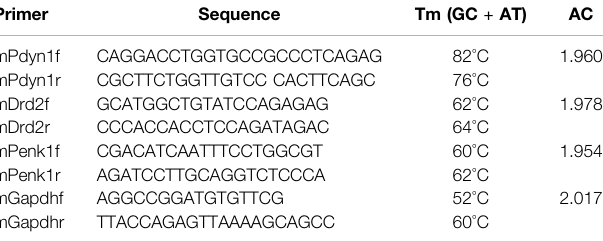
TABLE 2 | qRT-PCR primers validated, selected and used in this